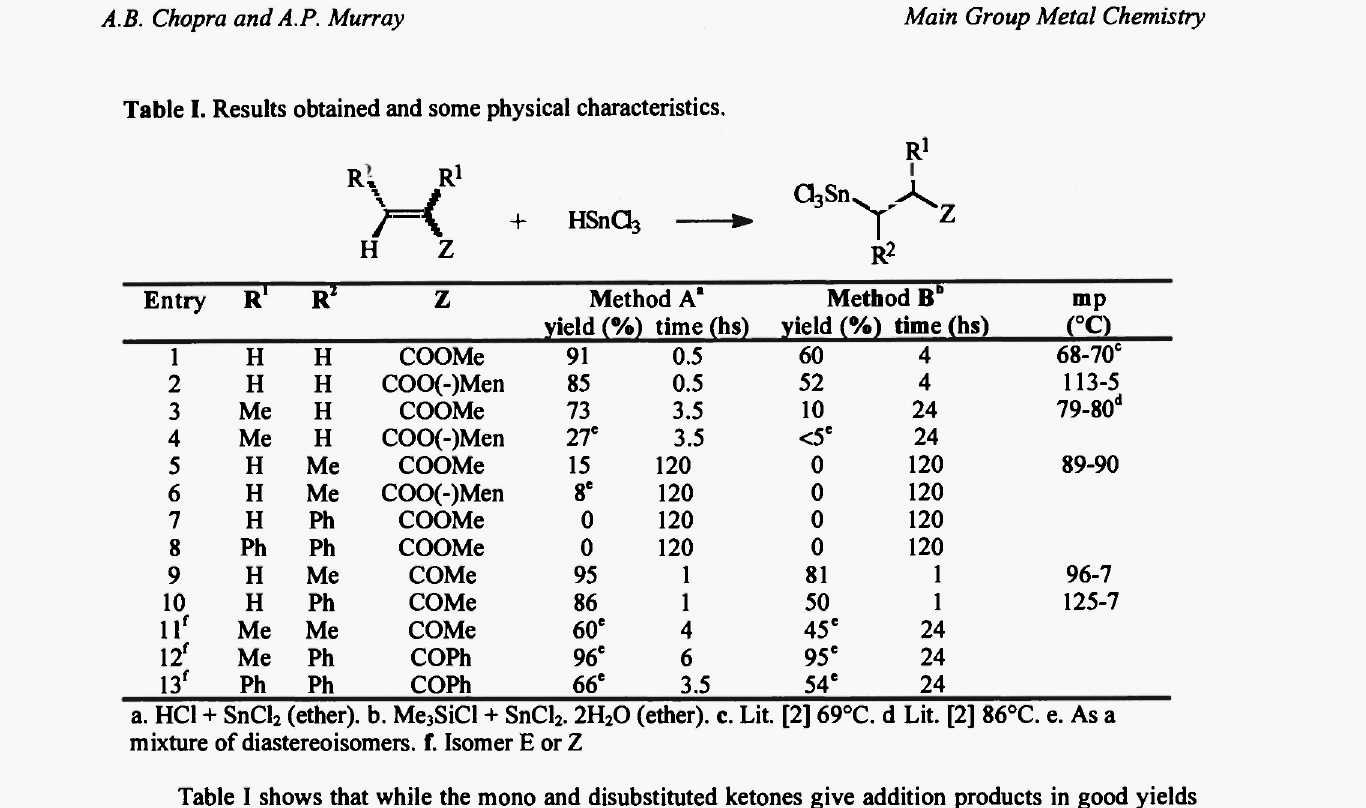
Table I. Results obtained and some physical